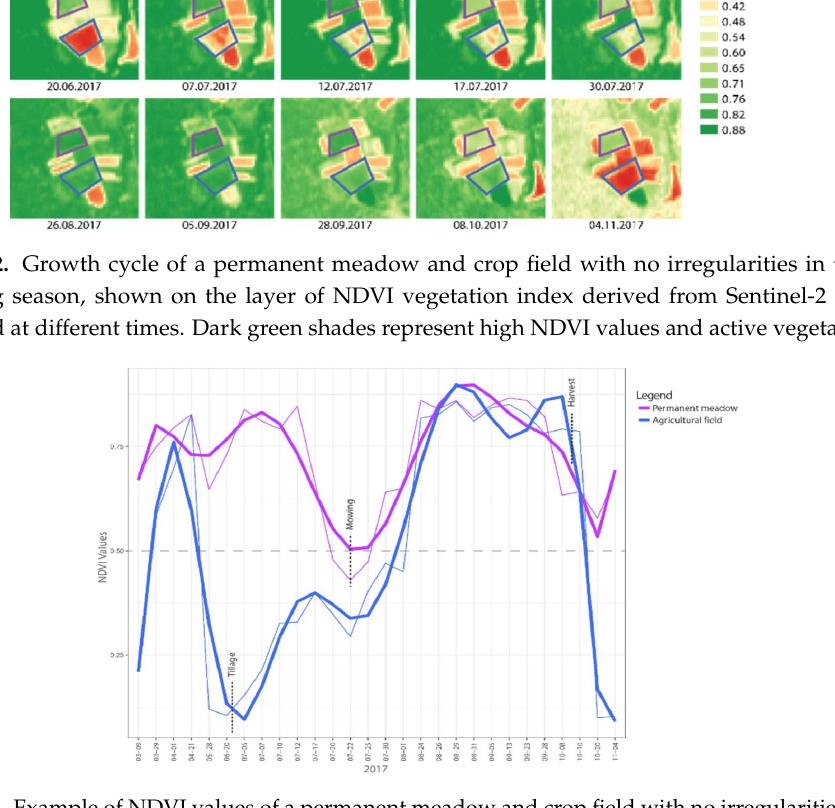
Figure 3. Example of NDVI values of a permanent meadow and crop field with no irregularities during the 2017 growing year (thick lines represent linear smoothing). In the case of a permanent meadow, a drop of values appropriately corresponds to the mowing season, whereas in the case of crop field a drop represents tillage or